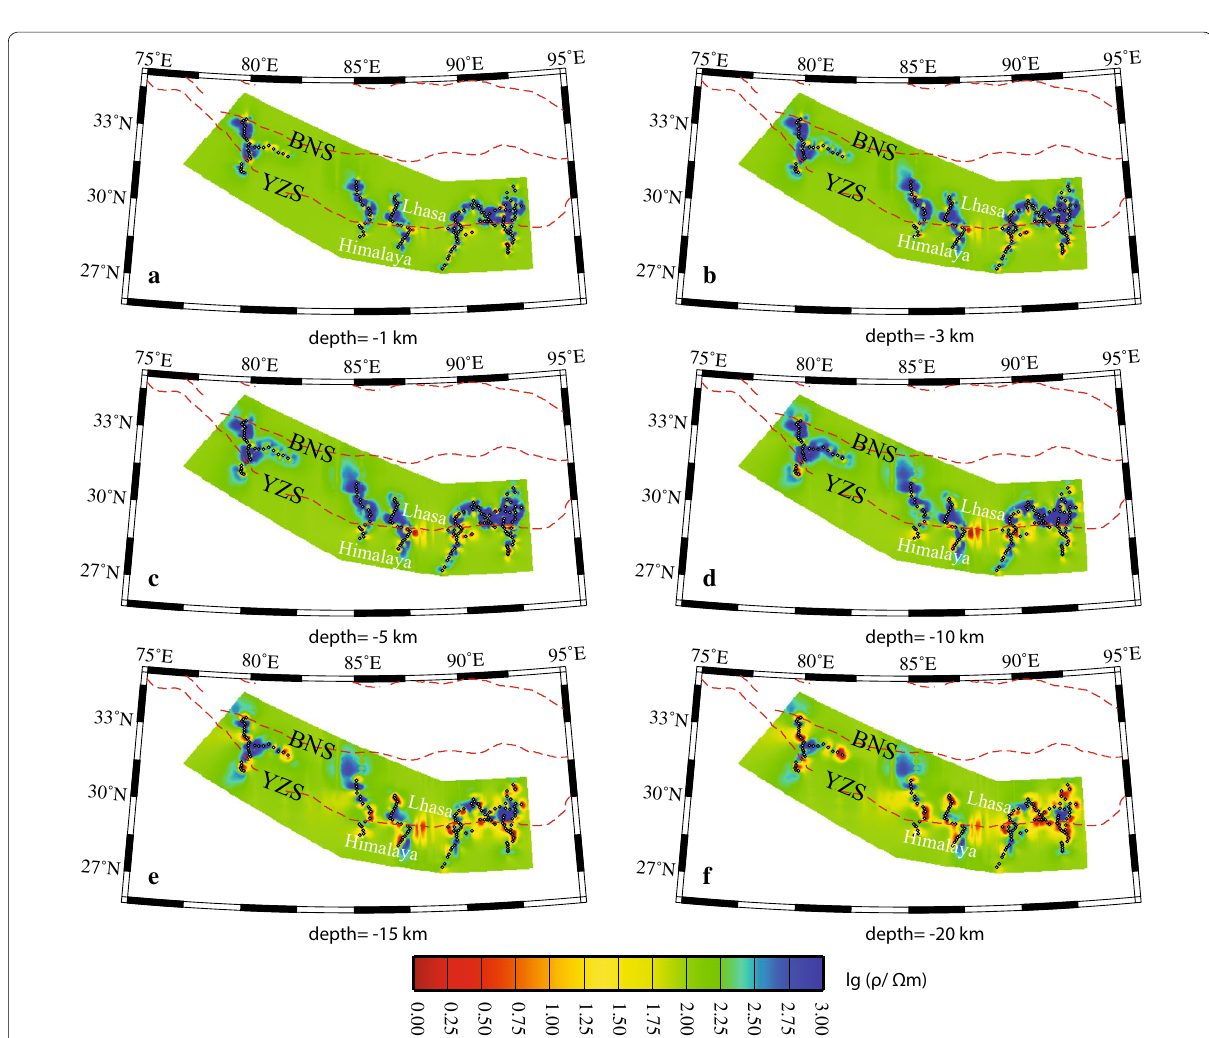
Fig. 6 Horizontal slices of the electrical model from shown in red while the high resistivity are shown in blue. Panels a to f are for depths from